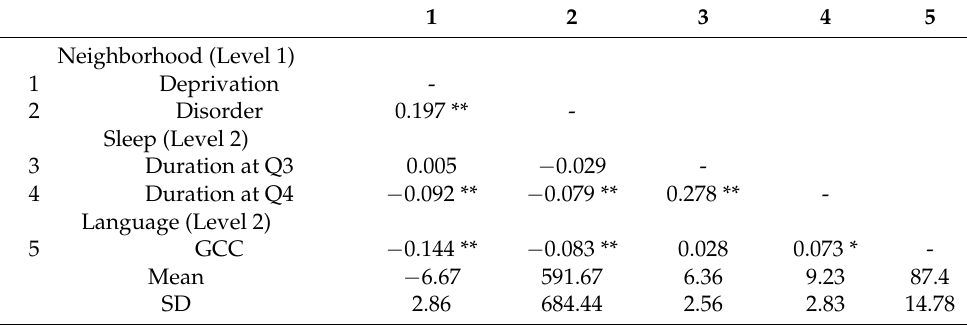
Table 2. Descriptive statistics and correlations for main variables.